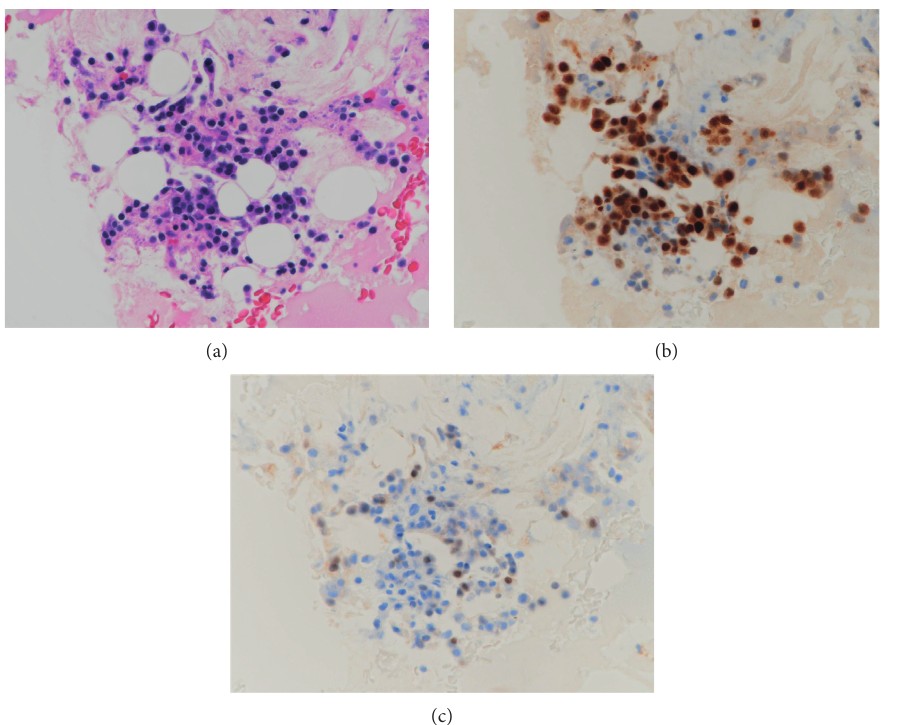
Figure 1: Pathological and immunohistochemical findings of bone marrow clot samples. (a) Hematoxylin and eosin staining showing infiltration of small-sized atypical plasma cells with eccentric nuclei. (b) Plasma cells were strongly positive for cyclin D1. (c) Plasma cells exhibited partial and weak MYC expression. Magnification: